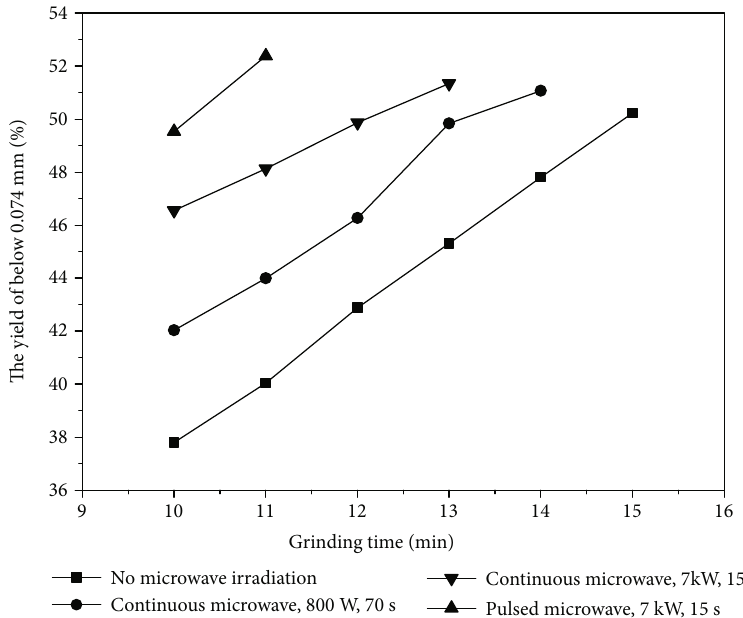
Figure 11: The in fl uence of ball milling time on the grinding fi neness of lead-zinc ore after microwave